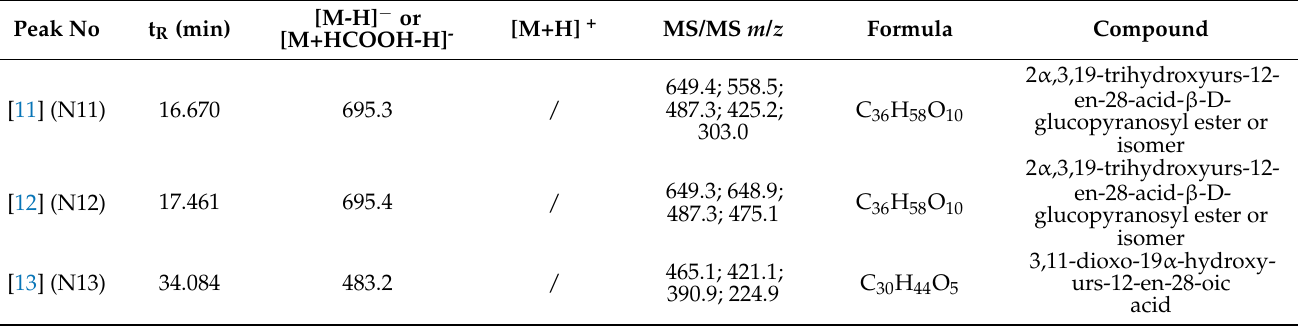
Table 4. Fragment ions of new components in Sanguisorba officinalis L. after